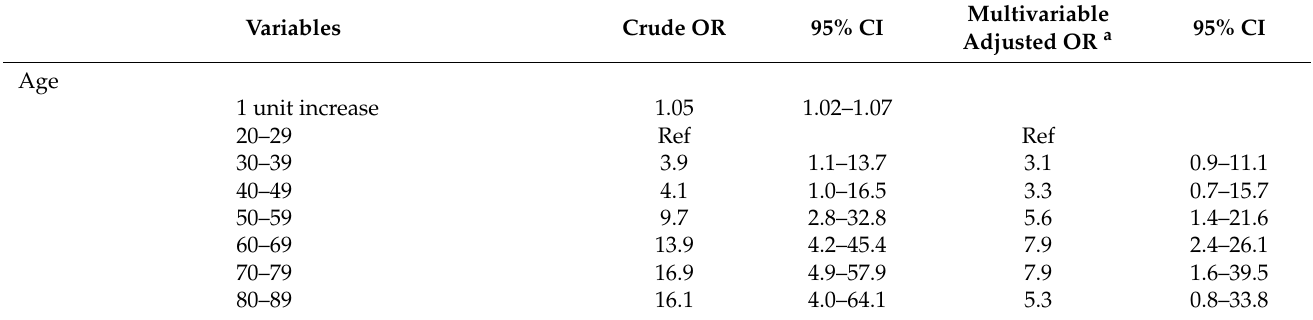
Table 3. Multivariable analysis for factors associated with non-obese